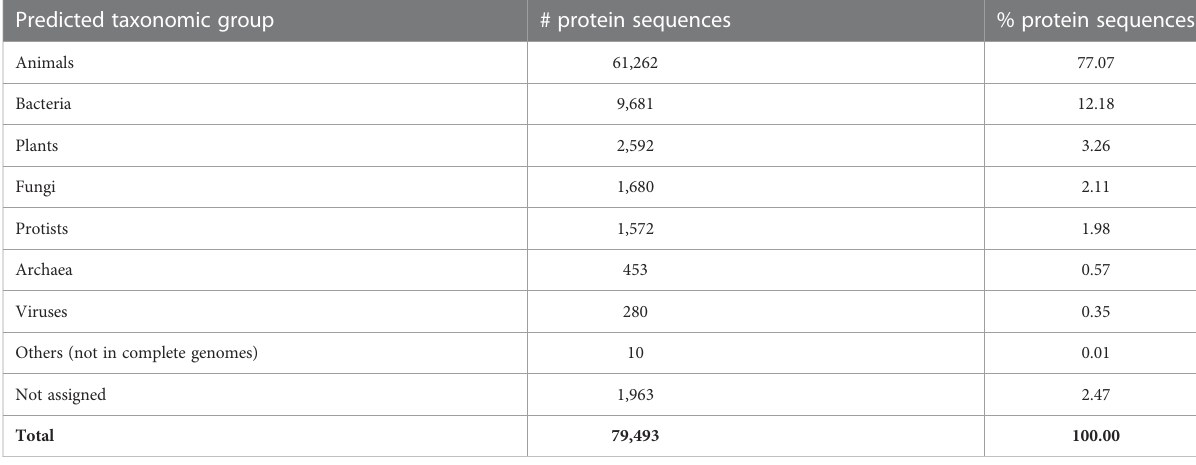
TABLE 3 Broad taxonomic classi fi cation of protein sequences annotated from the combined S. methanicola metagenomes by ghostKOALA, based on mapping to complete genomes or functionally characterized individual protein sequences in the KEGG Genome database. Predicted taxonomic